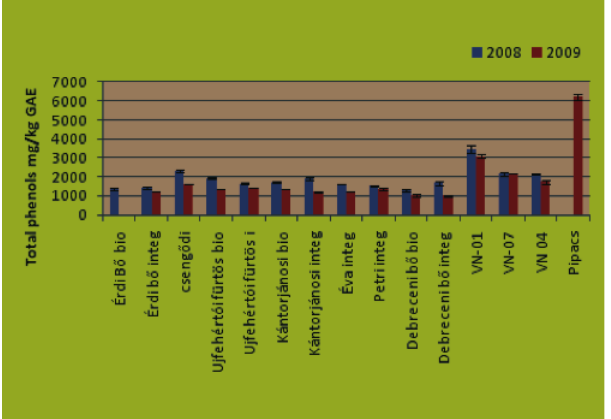
Figure 3: Principal component analysis, score plot of sour cherry data